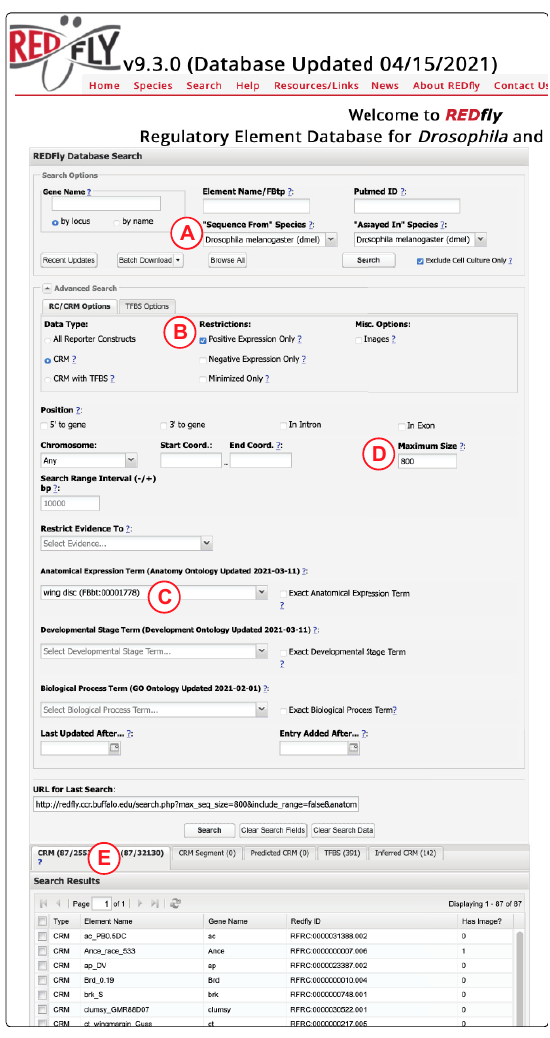
Figure 1. The REDfly search interface. Researchers can make use of REDfly’s comprehensive search capabilities to assemble sets of CRMs with specific properties. In this example, for instance, over 25,000 “CRM” records will be searched for ( A ) sequences belonging to the Drosophila melanogaster genome that ( B ) positively regulate gene expression in the ( C ) wing imaginal disc, and that are ( D ) no greater than 800 bp in length. Results are listed in the Results Table ( E ). Clicking on an individual result opens a Detailed Results window with extensive further information, or multiple records can be selected using the checkboxes for download in a variety of